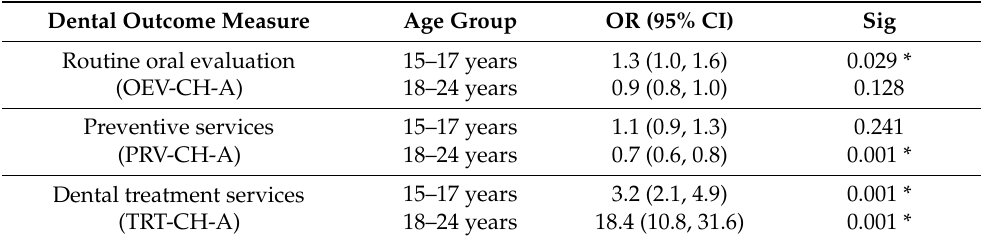
Table 4. Binary logistic regression models for the associations between cost of care and dental care